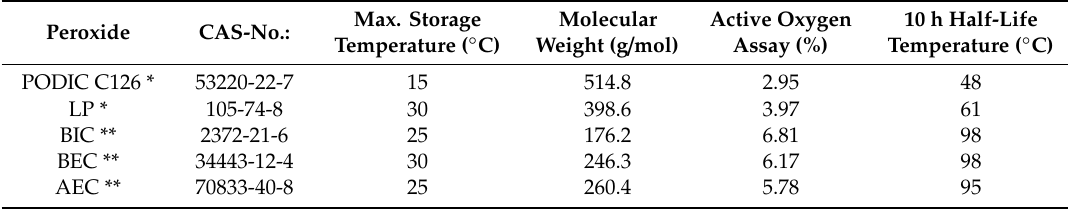
Table 1. Characteristics of the peroxides.